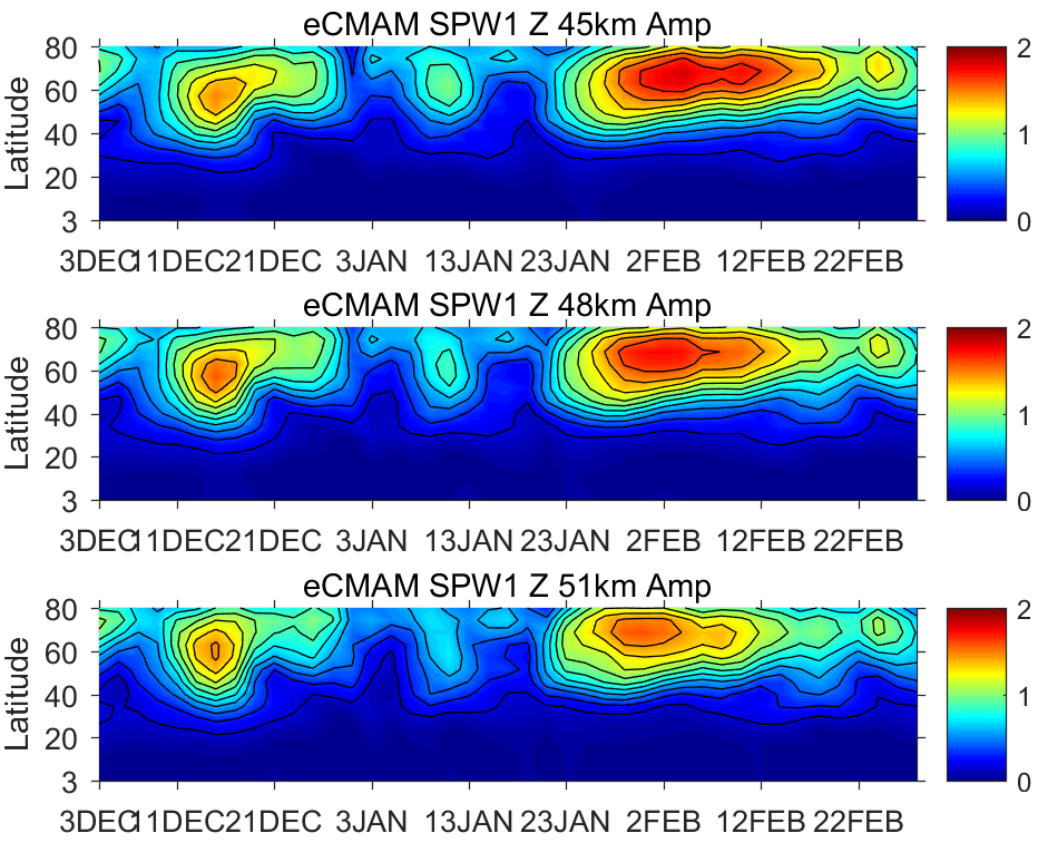
Figure 2. Latitude versus time variations of SPW1 Z amplitude in the eCMAM during December 2009–February 2010 at 45, 48, and 51 km.